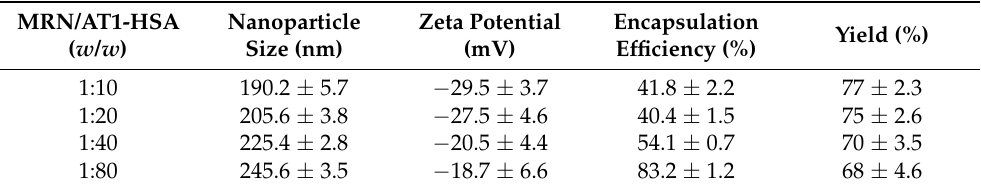
Table 1. Nanoparticle size, charge, encapsulation efficiency, and yield at various MRN/AT1-HSA ( w/w ) ratios of nanoparticle